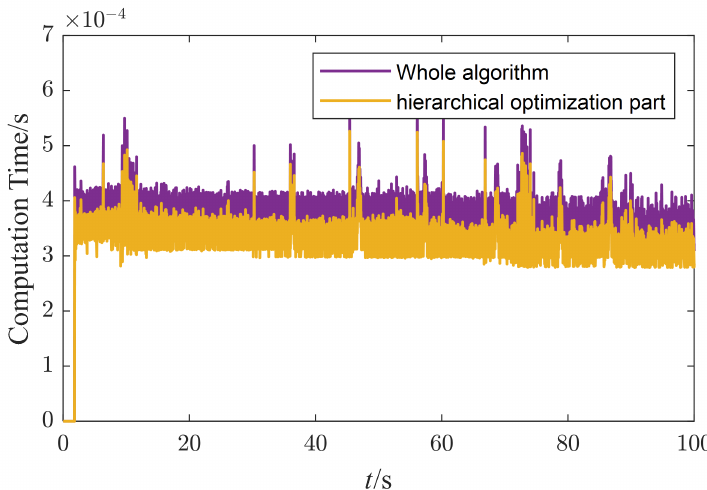
Figure 14. The computation time of the